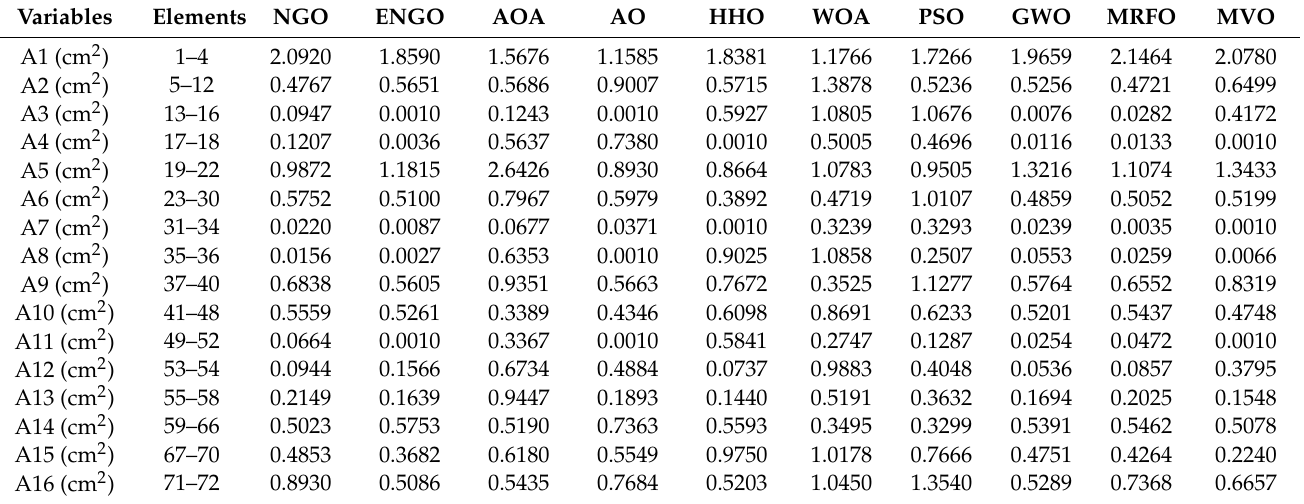
Table 12. The best solutions of the 72-bar truss design problem obtained by the different